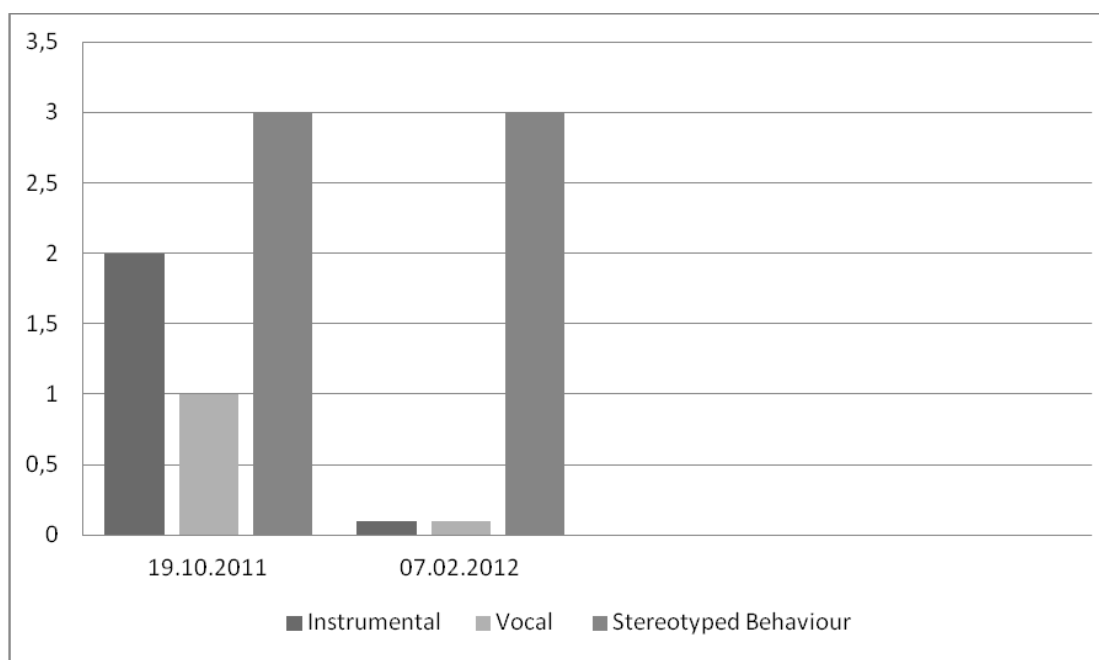
Source: Chart based on Scale II Musical Communicativeness Rating Form (Nordoff, Robbins, 2007, p.